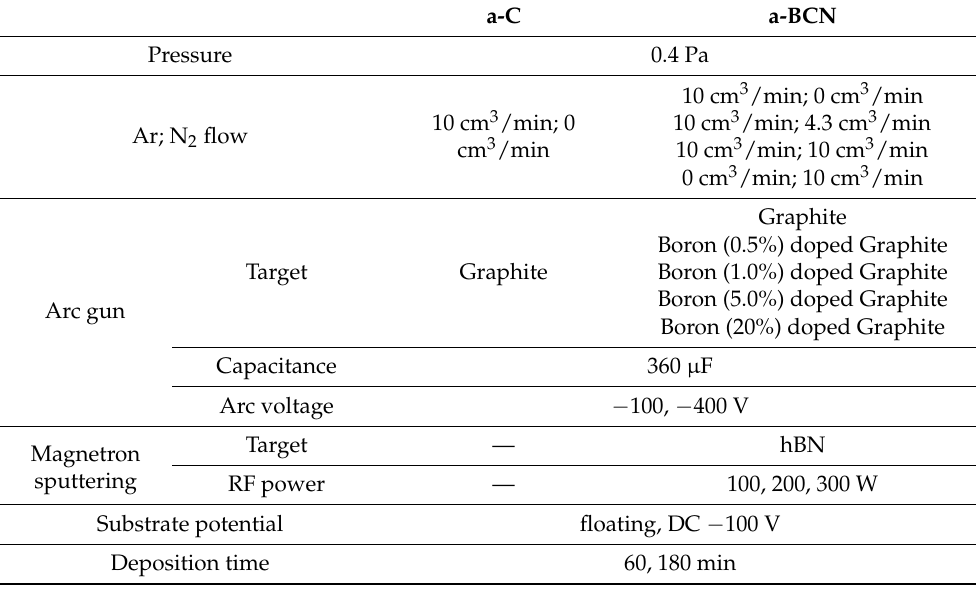
Table 1. Deposition conditions for amorphous carbon (a-C) film and amorphous boron carbon nitride (a-BCN) films. a-C a-BCN Pressure 0.4